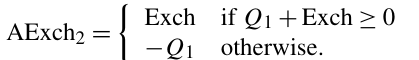
Table B1. Parameter ranges and transformation functions for GR6J model calibration. To make calibration easier, the original parameter search ranges presented below are transformed to [ − 9 . 99, 9.99] by each transformation function. The values found are then re-transformed into parameter values using reciprocal transformation. Details can be found in Sect. 3.1.2.